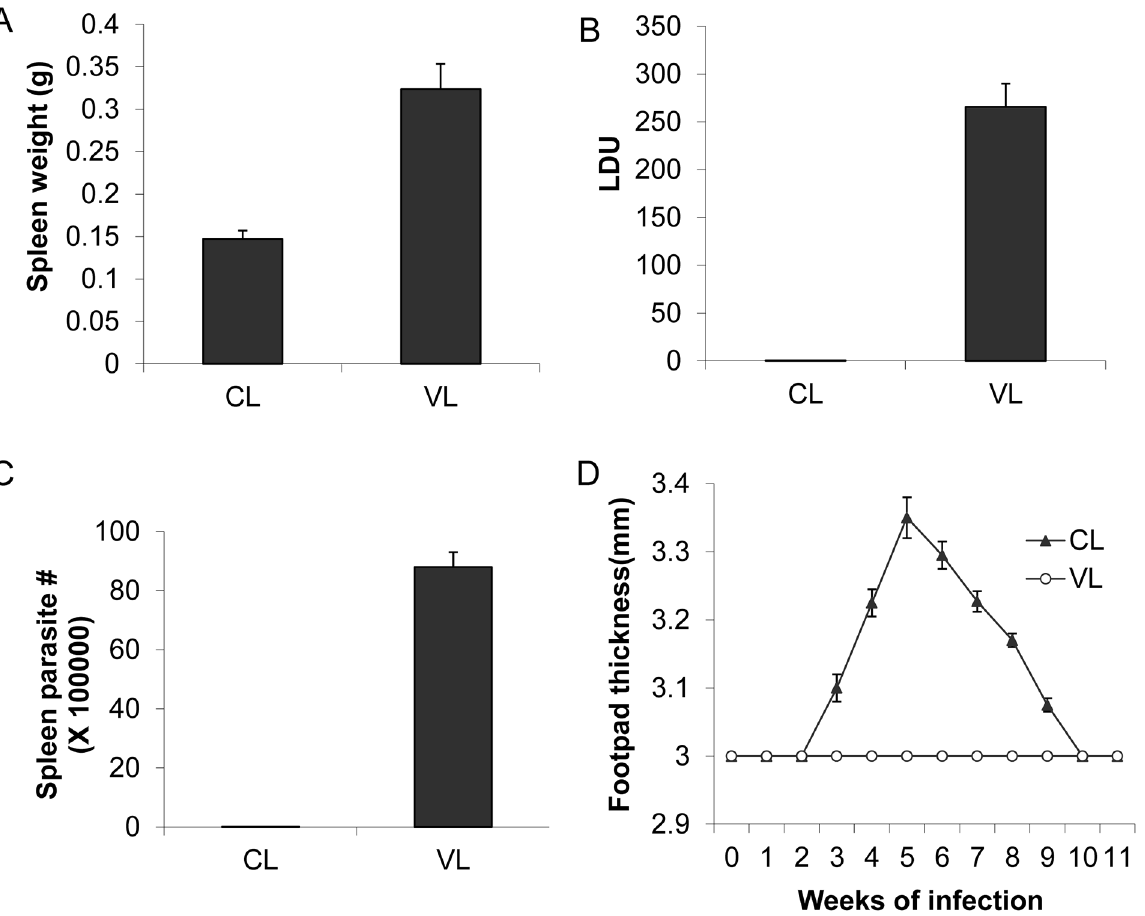
Figure 1. The L.donovani CL-SL (CL) and VL-SL (VL) strains cause different pathology in BALB/c mice. For visceral infection, BALB/c mice (5 mice/group) were infected in the tail vein with 5 6 10 7 stationary phase promastigotes and 4 weeks after infection, mice were examined for spleen weight and parasite burden in the liver (Leishman Donovan Units: LDU) and spleen (parasite numbers) as determined by limiting dilution of spleen homogenates. The VL-SL strain (VL) infection in mice resulted in splenomegaly ( Panel A ) and high levels of infection in the liver ( Panel B ) and spleen ( Panel C ) compared to the CL-SL strain (CL) that caused negligible infection levels in the liver and spleen. Values plus standard error are shown. Panel D , cutaneous infections, BALB/c mice (5 mice/group) were injected subcutaneously in the rear footpad with 5 6 10 6 stationary phase promastigotes and footpad lesion development was measured over 11 weeks.